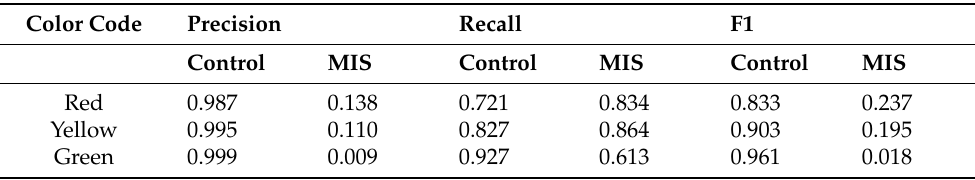
Table 4. Cross-validation performances across color